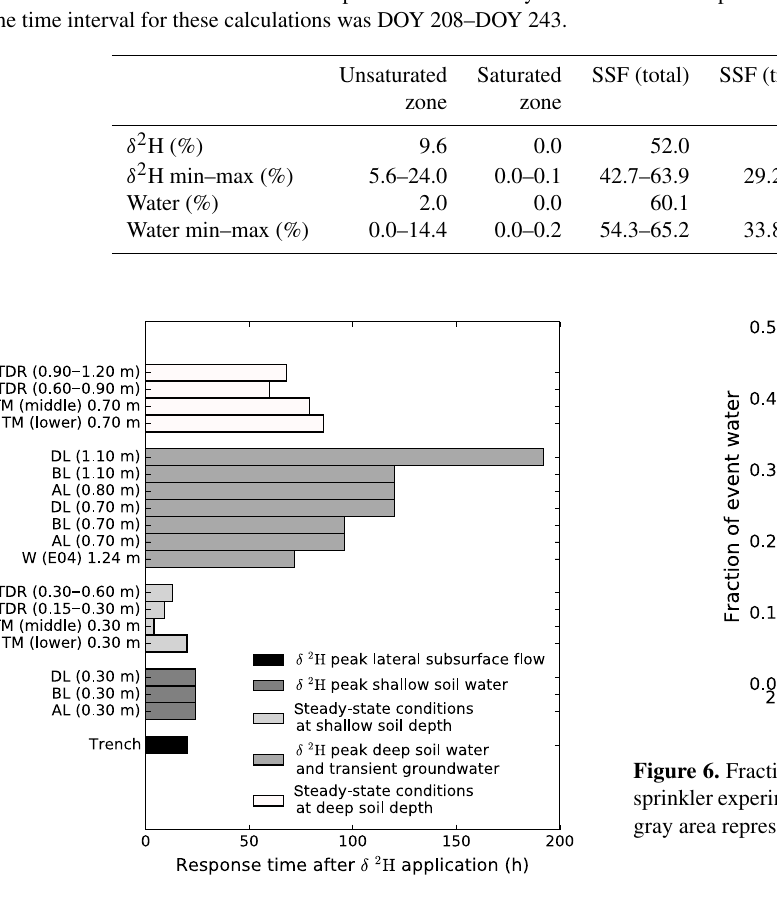
Figure 5. Tracer response time ( δ 2 H peak) observed at porous cup lysimeter nests AL, BL and DL, in lateral subsurface flow at the trench and in well E04, relative from the start of the δ 2 H applica- tion. Additionally, the response time of steady-state soil water con- tent measured by TDRs and steady-state soil matric potential mea- sured by tensiometer nests (TM), relative from the start of the δ 2 H application, are shown.